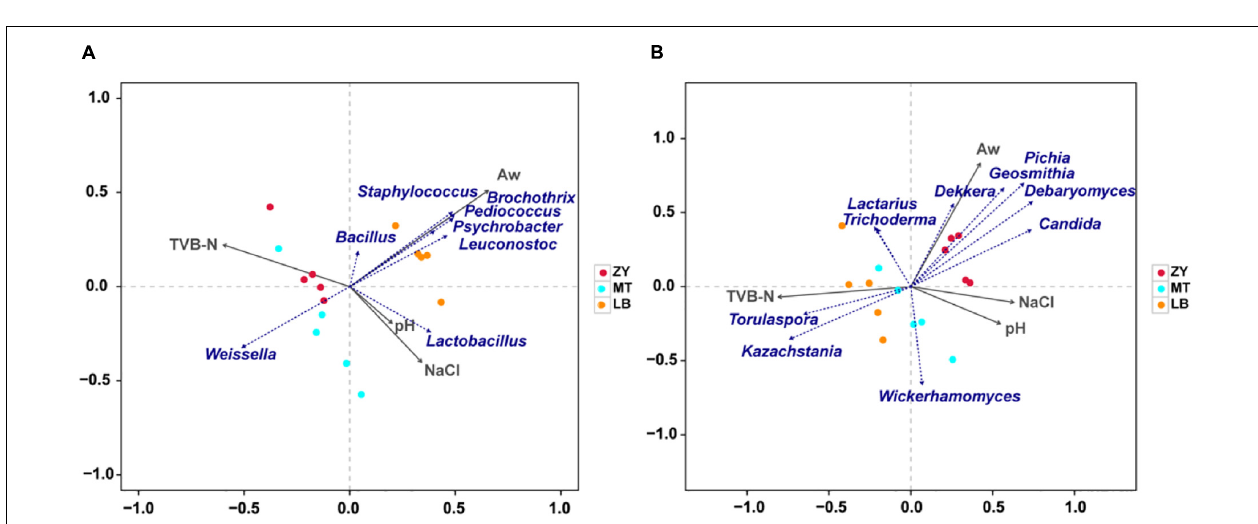
FIGURE 6 | (A) RDA of microorganisms (Top 10 of OTU) and physiochemical properties. Correlation between physiochemical properties and fungal genera. (B) Correlations between physiochemical properties and bacterial genera.